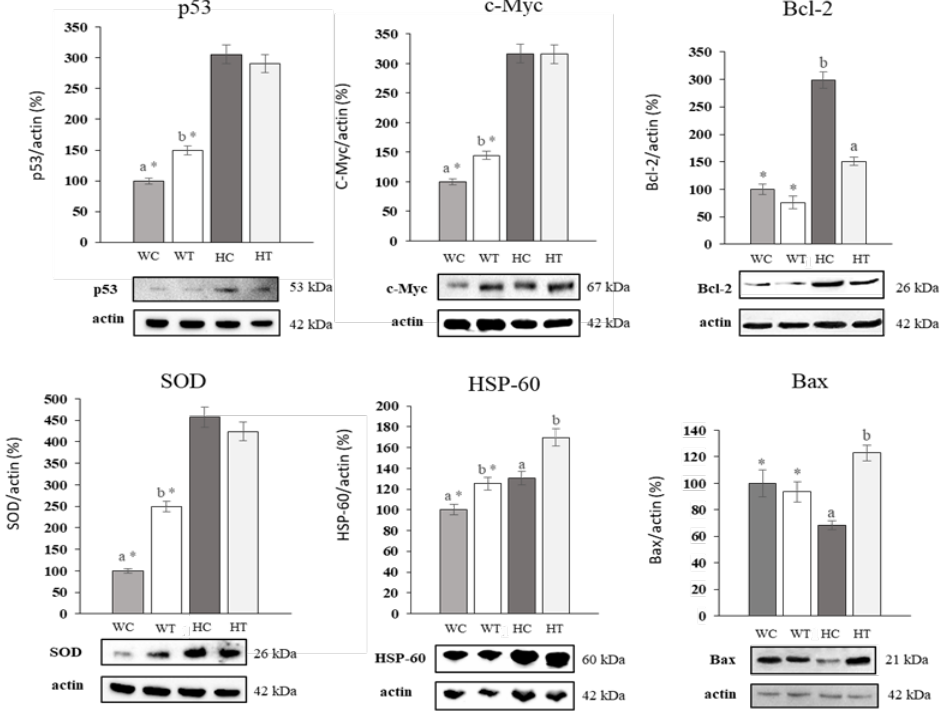
Figure 7. Western-blot analysis of p53 , c-Myc , Bcl-2 , SOD , HSP-60 and Bax protein levels in WRL68 and HepG2 cells, untreated (WC and HC) and exposed to IC 50 of uvaol for 24 h (WT and HT). The quantification of protein levels by densitometric analysis is shown in bar graphs. The results are the means ± SEM (n = 9) and are expressed as percentage of expression compared to actin. WRL68 values were used as 100% of expression and the rest of treatments were referred to them. Different letters indicate significant differences between treatments for each cell line and an asterisk indicates significant differences between cell lines for each treatment ( p < 0.05).